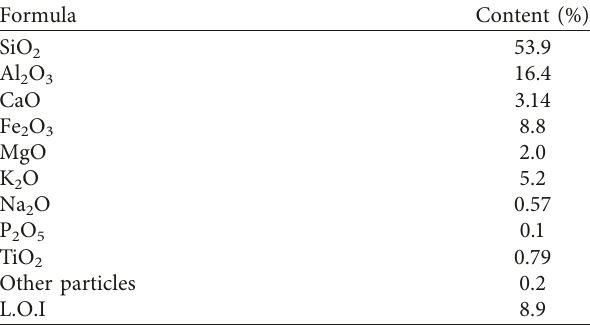
Table 3: Chemical compositions of the studied high-plasticity clay soil (obtained from X-ray fluorescence analysis).